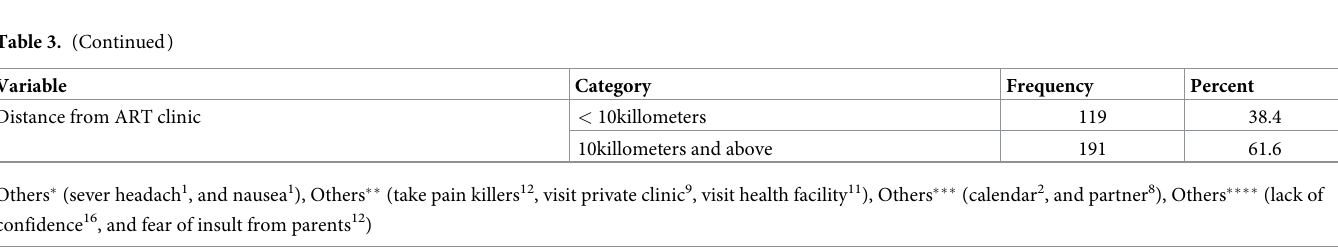
Non-adherence to ART led to HIV-related morbidity and mortality [38, 39]. Our study revealed that ART non-adherence level based on self-report at the time of follow up was 17.4% (95% CI: 12.8%, 21.2%), higher than the findings of the studies in Southwest Ethiopia [17], Uganda [33]. The discrepancy could be due to differences in the study setting and the existence of socio-cultural differences of the participants.